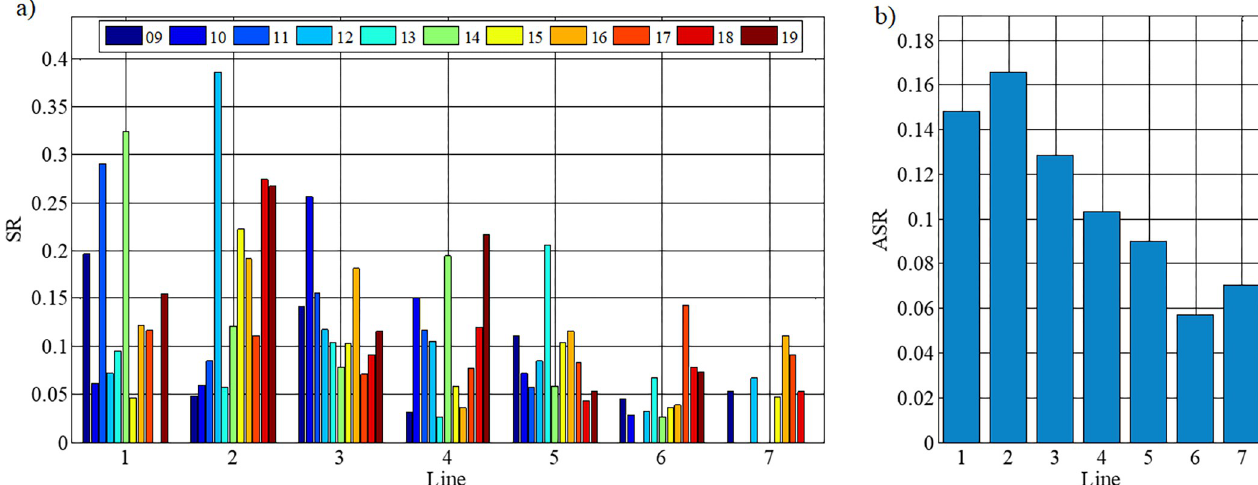
Fig 5. Values of pedigree effectiveness factor in a given year (SR) and the average value of the pedigree effectiveness factor from all starts (ASR). The line were marked with numbers: 1—Gurgul, 2—Goral, 3—Hroby, 4—Ousˇor, 5—Pietrosu, 6—Polan, 7 –Prislop.